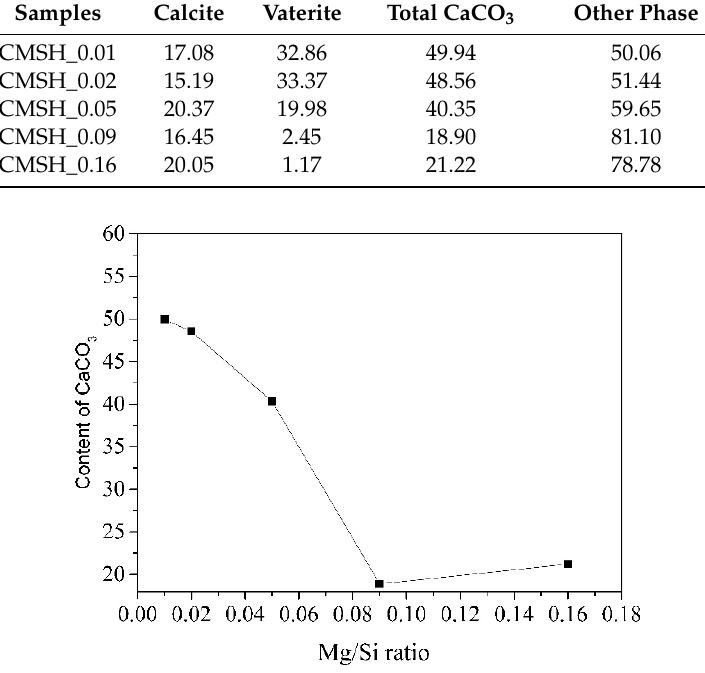
Figure 9. The e ff ect of Mg / Si ratio on the content of CaCO 3 Figure 9. The effect of Mg/Si ratio on the content of CaCO 3. Table 5. The effect of Al/Si ratio on the content of calcite and vaterite.